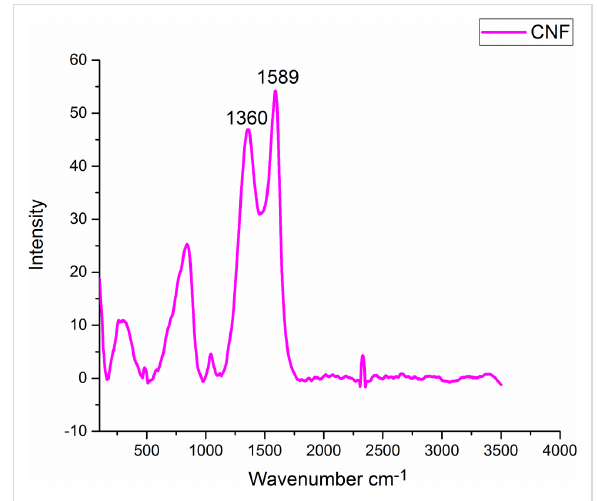
Figure 7: Raman spectrum of carbon nanofiber webs.